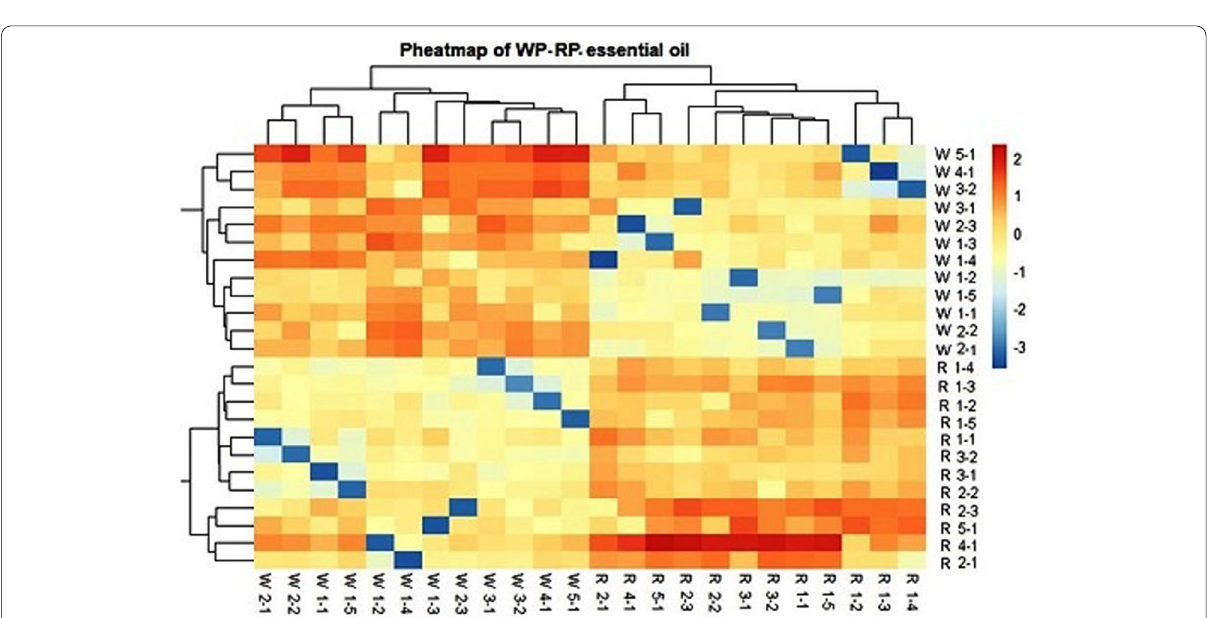
Fig. 7 Heatmap illustrating the relatedness of the wild accessions and regenerated genotypes based on the variation of chemical constituents of the essential